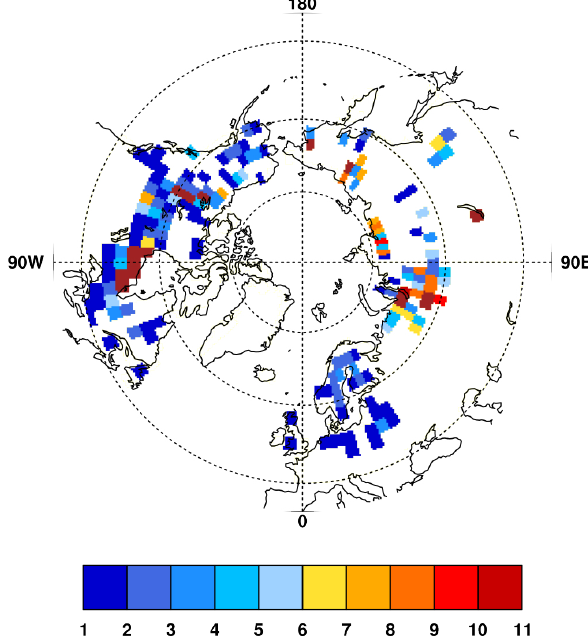
Fig. 9. Peatland soil carbon stocks at the end of the spin-up [TgC per grid-cell area]